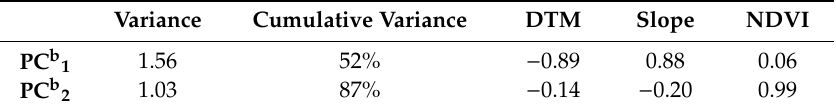
Table 7. Results of PCA applied in the area ‘b’: variance of the principal components considered in CA and correlation coe ffi cients with the variables used to delineate